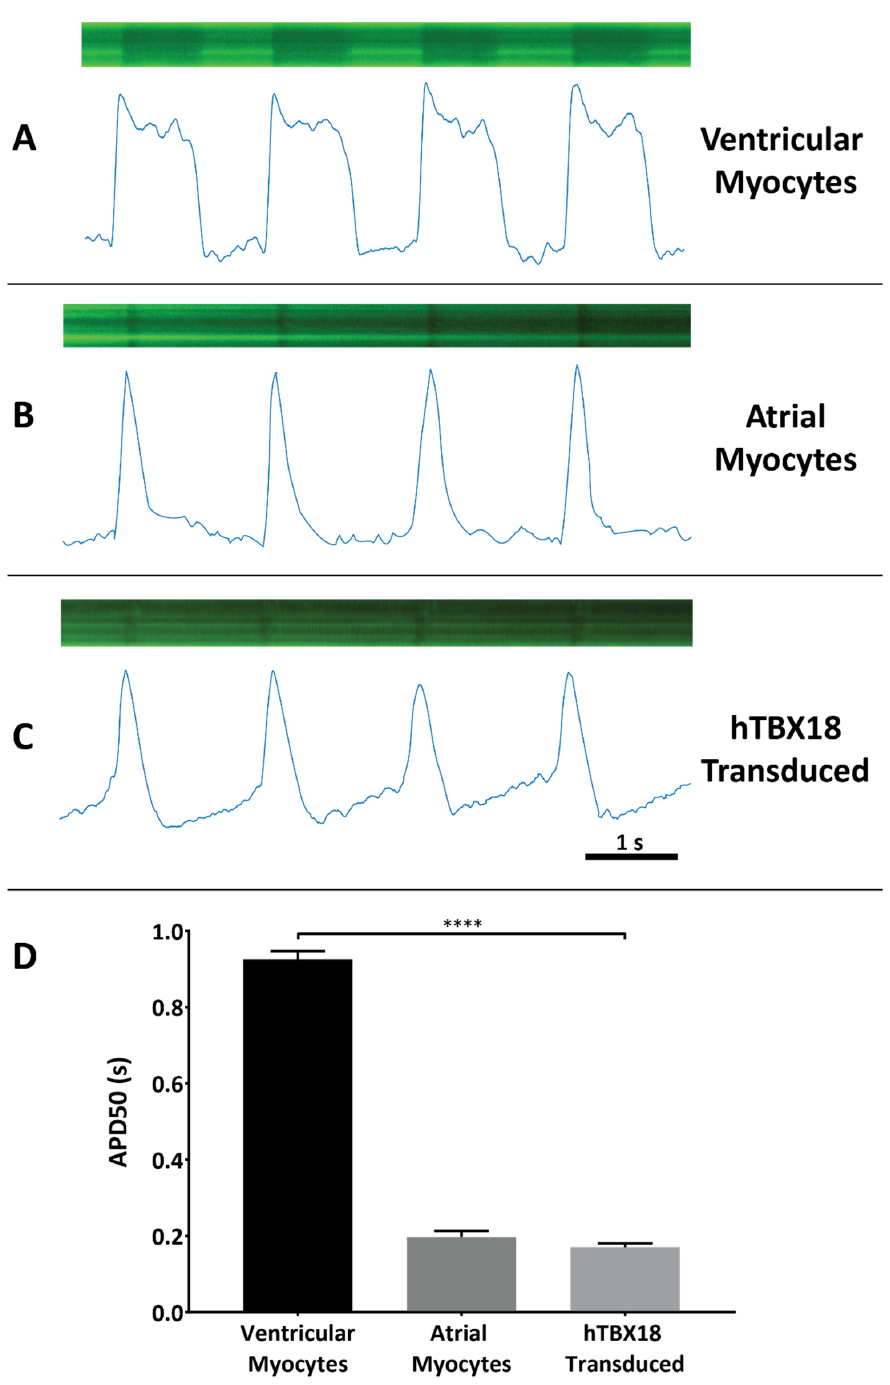
Figure 6. Pacemaker-like cell function was observed in hTBX18 -transduced NRVMs. Action potentials recorded and analyzed from NRVMs and hTBX18 -transduced cells using LV. Arclight co-transduction. Representative images of Arclight expression as generated by the confocal line scan protocol and the action potentials generated after analysis via MATLAB for ( A ) NRVM cells, ( B ) atrial myocyte cells ( C ) and rAAV6- hTBX18 -transduced cells. ( D ) Quantification of the AP morphology using the APD50 measure. Data presented as mean ± SEM. **** p- value ≤ 0.0001.